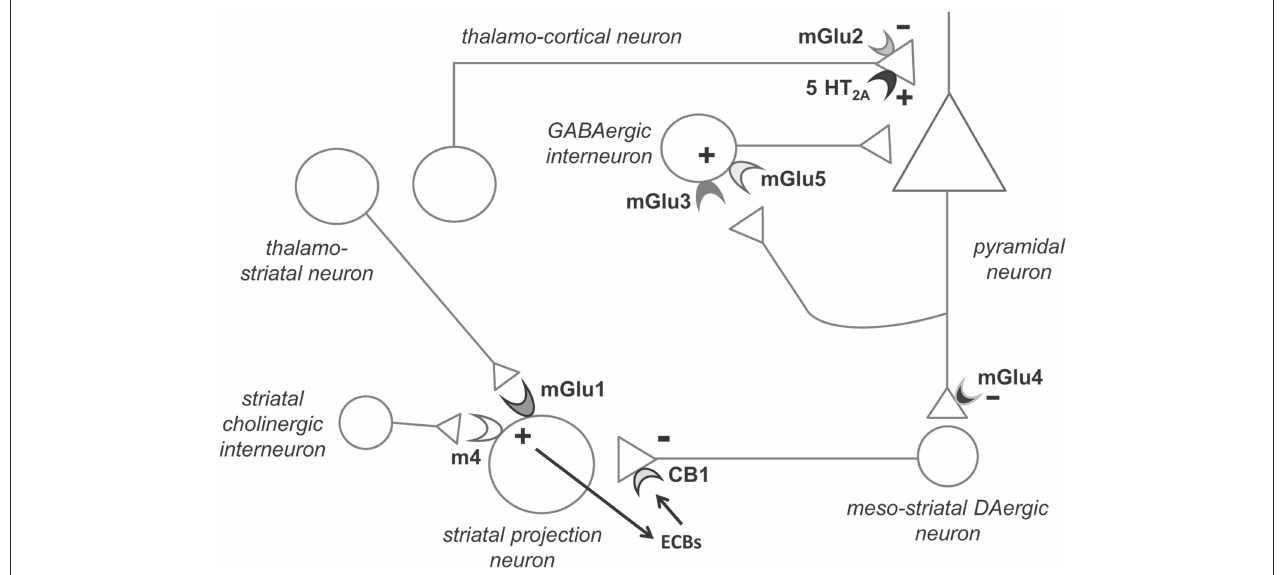
FIGURE 1 | Hypothetical model highlighting the potential role of individual mGlu receptor subtypes in the pathophysiology and treatment of schizophrenia. Presynaptic mGlu2 receptors negatively modulate 5-HT 2A receptor signaling, and their activation restrains glutamate release at synapses between thalamo-cortical neurons and cortical pyramidal neurons (see chapter 6). mGlu5 receptors are found in both pyramidal neurons and interneurons (shown here) and functionally interact with NMDA receptors. mGlu5 receptor PAMs are under development for the treatment of schizophrenia (see chapter 4). Recent evidence indicates that mGlu3 receptor activation boost mGlu5 receptor signaling, and, therefore, selective mGlu3 receptor agonists or PAMs should be tested in preclinical models predictive of antipsychotic activity (chapter 3). The functional cross-talk between mGlu3 and mGlu5 receptors has been shown in pyramidal neurons (6). We speculate that the two receptors also interact in GABAergic interneurons, but this remains to be demonstrated. mGlu1 receptors and type-4 muscarinic cholinergic receptors (M4) interact in stimulating the production of endocannabinoids (ECBs) in striatal projection neurons. ECBs activate presynaptic CB1 receptors, thereby reducing dopamine (DA) release from meso-striatal terminals. Hence, mGlu1 receptor PAMs might be effective in improving positive symptoms in schizophrenia (chapter 5). Finally, mGlu4 receptor agonists/PAMs are effective in animal models that are predictive of antipsychotic activity. mGlu4 receptors might act to reduce glutamate release from excitatory nerve endings of pyramidal neurons and through other mechanisms. Not shown here: activation of mGlu3 and mGlu5 receptors may restrain neuroinflammation by driving microglia toward an antinflammatory phenotype, and activation of mGlu3 receptors stimulates the production of neurotrophic factors in astrocytes (see chapters 3 and